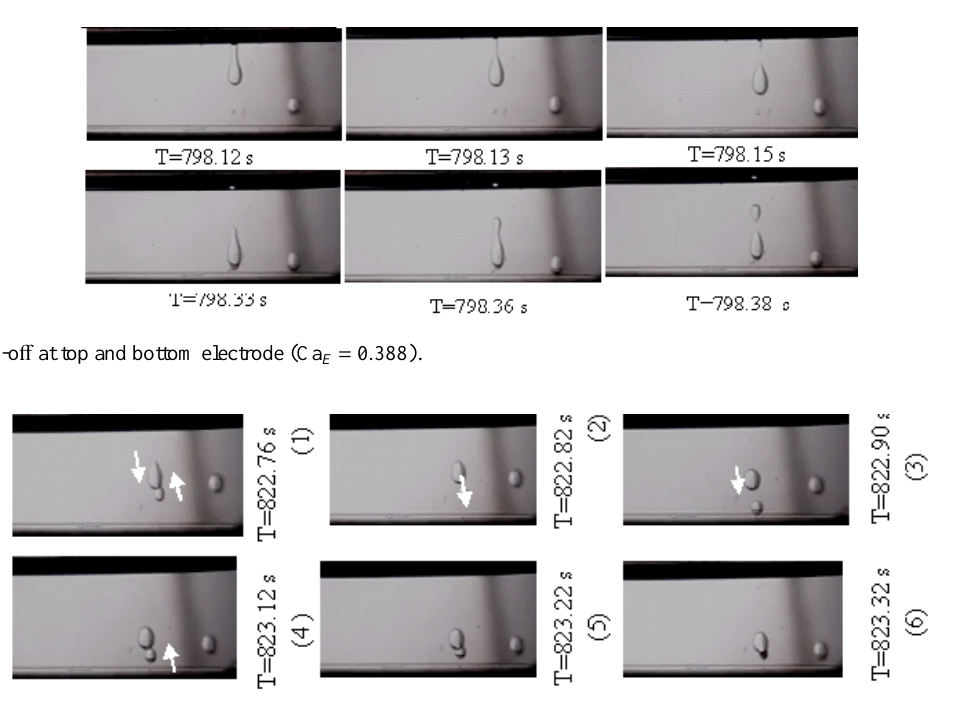
Figure 16. The third type of droplet coalescence (Ca E = 0 . 388). Fig. 16. The third type of droplet coalescence (Ca charged neighbor drop. Here, coalescence has been detected for two oppositely charged